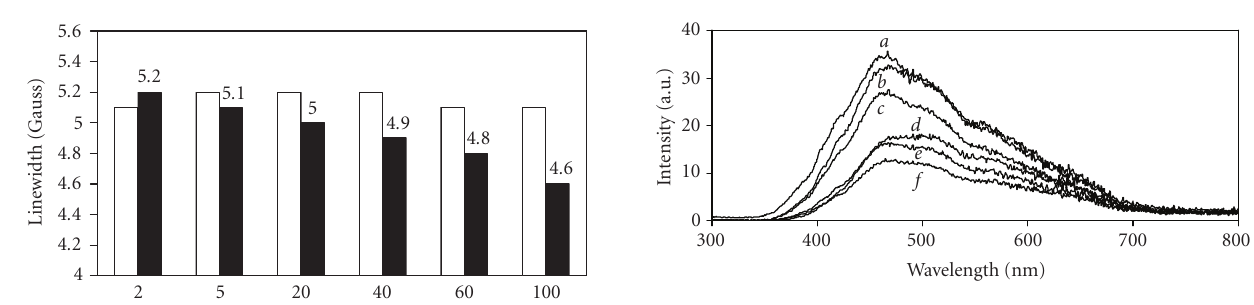
Figure 4: Synchronous fluorescence spectrum ( Δ λ = 20 nm) of Arabian petroleum. Irradiation times: (a) 0h, (b) 2 h, (c) 20 h, (d) 40 h, (e) 60h, and (f) 100